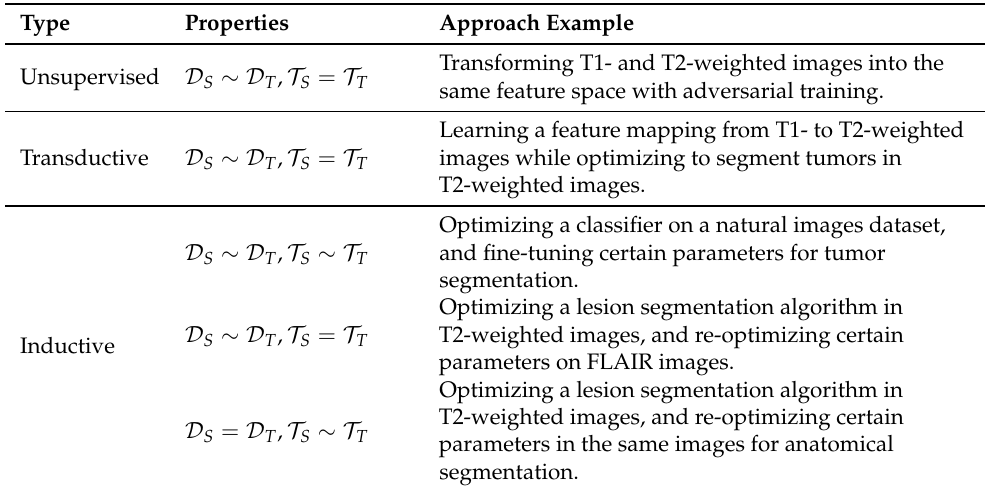
Table 1. Types of transfer learning and examples in MR brain imaging. ∼ indicates “different but related.” The subscripts S and T indicate source and target,